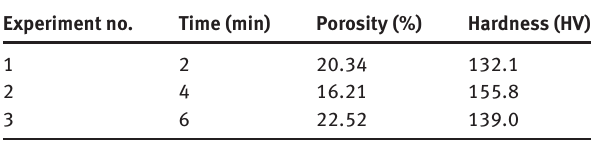
Table 3: Porosity and hardness values of the composites manufactured at 750 °C, 500 rev/min stirring speed and 6% reinforcement volume ratio in 2, 4 and 6 minutes.